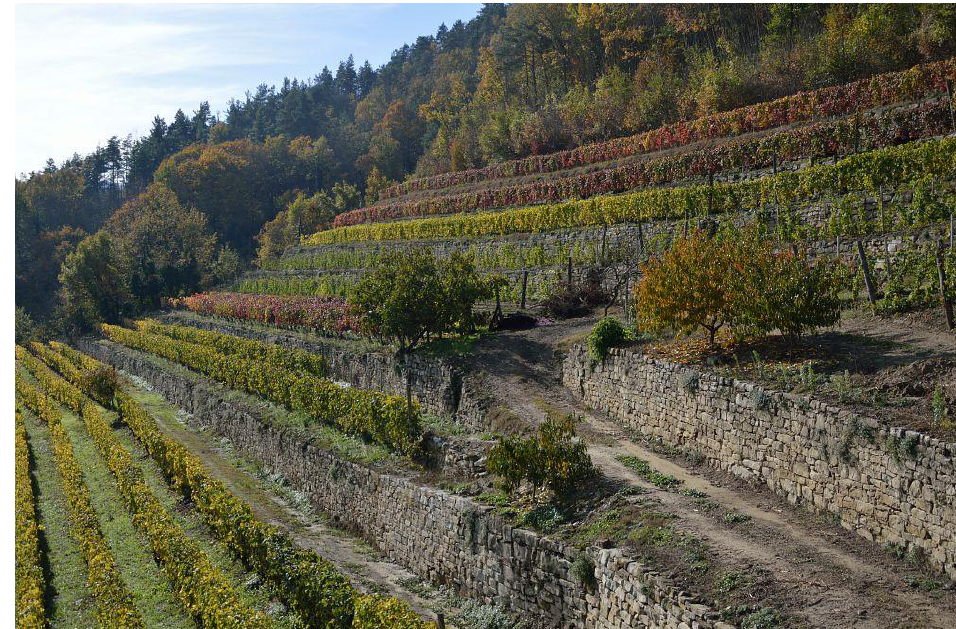
Figure 7. A traditional landscape of upper Bormida Valley.